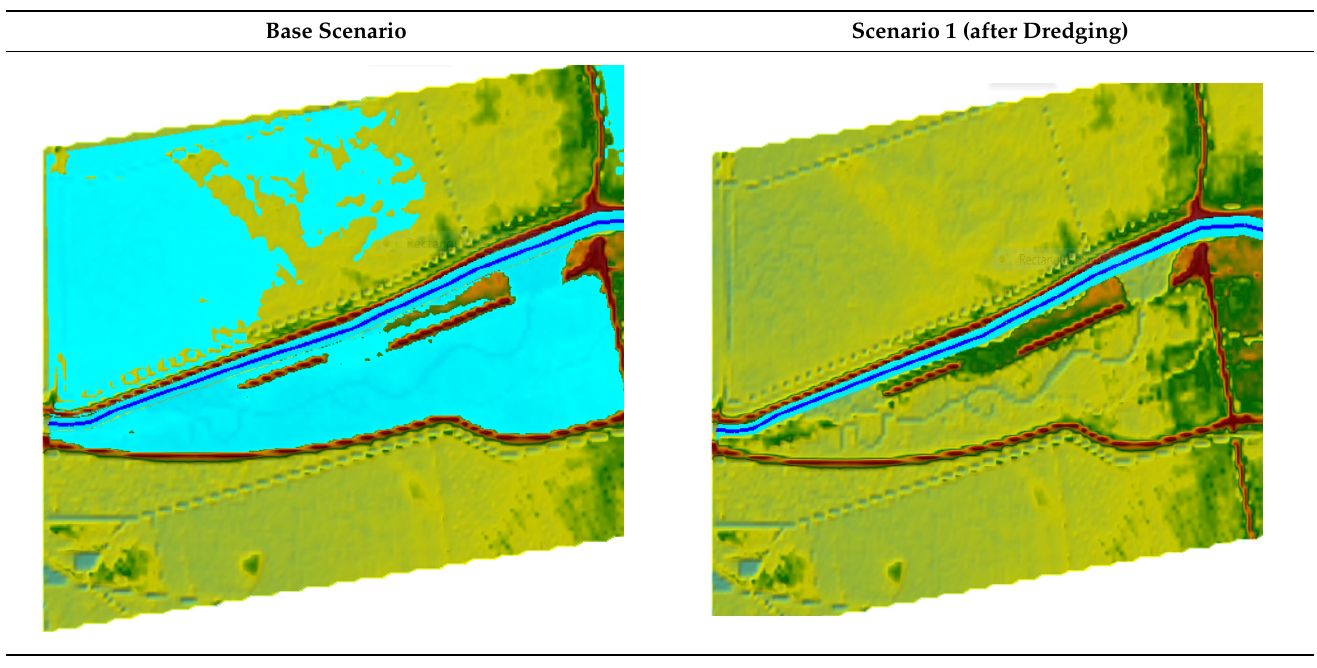
Table 7. Comparison of floodplain inundation between the base scenario and after-dredging scenario for sub-reach K6.